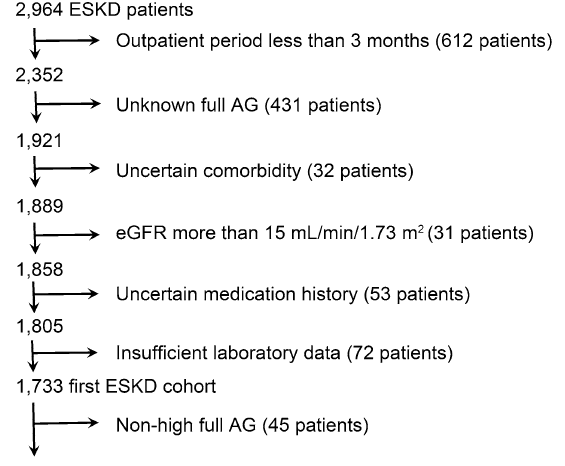
Figure 1. Flowchart showing the recruitment and screening of study participants. A total of 2964 non-dialysis patients with ESKD were recruited. Please note the difference between the first ESKD cohort and the second high full AG